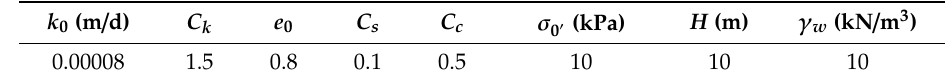
Figure 9. The calculation diagram for all three cases. Table 2. Calculation parameters. Table 2. Calculation parameters.